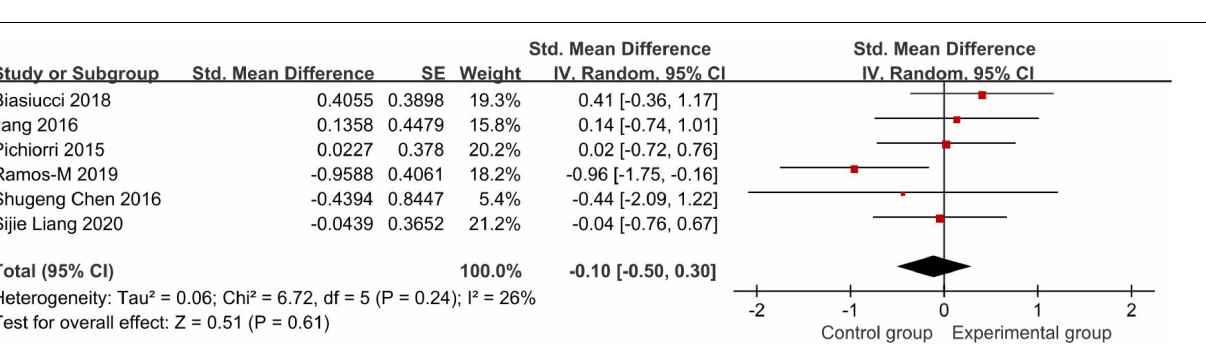
FIGURE 7 | Modified Ashworth Scale (MAS) to evaluate the effect of BCI on upper limb dysfunction after